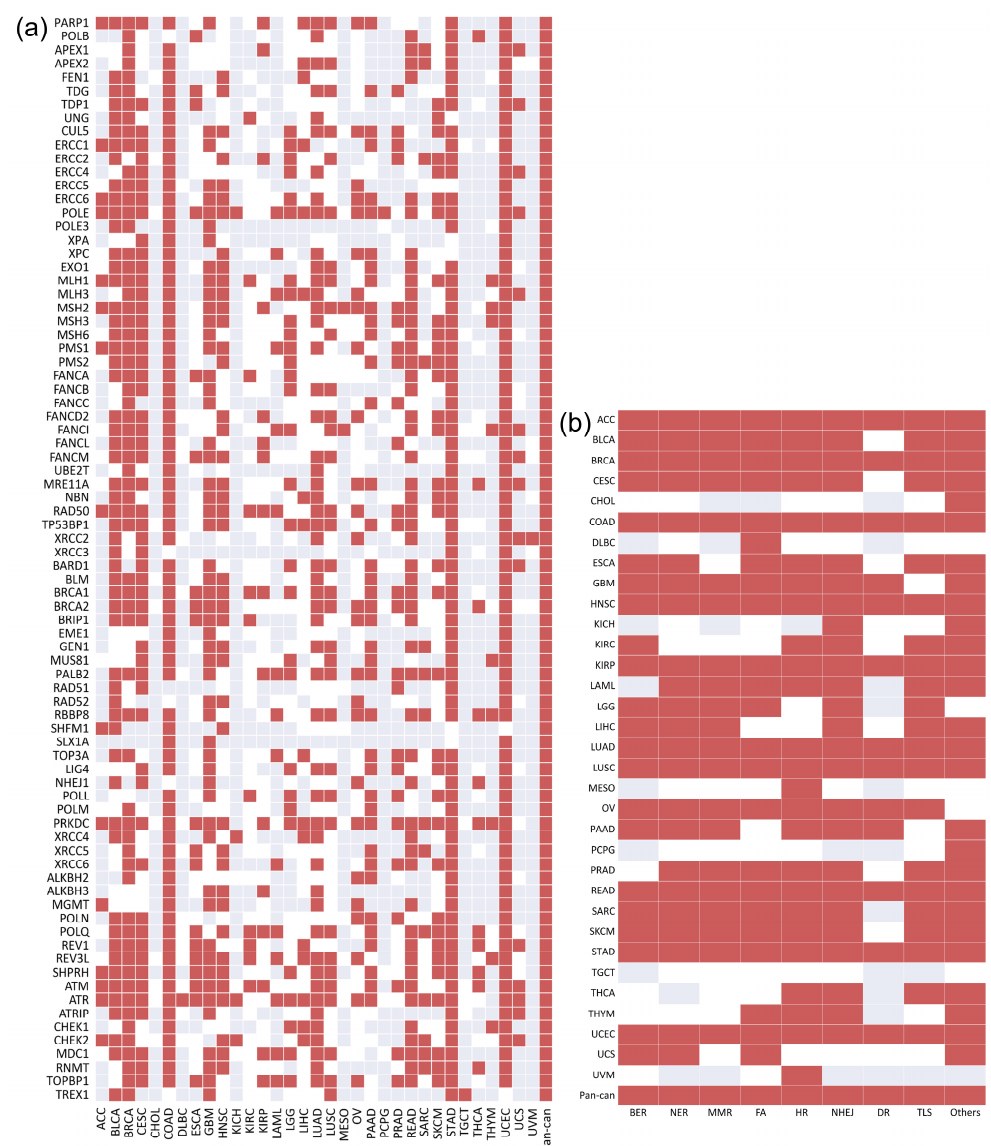
Figure 2. The association between TMB and the mutation status of the 80 DDR core genes/9 core DDR pathways in 33 cancer types and pan-cancer: ( a ) shows 80 DDR core genes. The density of the significant DDR core genes in the heatmap is approximately 0.6053; ( b ) shows 9 core DDR pathways. The density of the significant core DDR pathways is approximately 0.7645. Red indicates that the mutation status of the specific gene/DDR pathway is significantly associated with high TMB. White indicates that mutation in the specific gene/DDR pathway has no significant association with high TMB. Gray indicates that there is no mutation in this specific gene/DDR